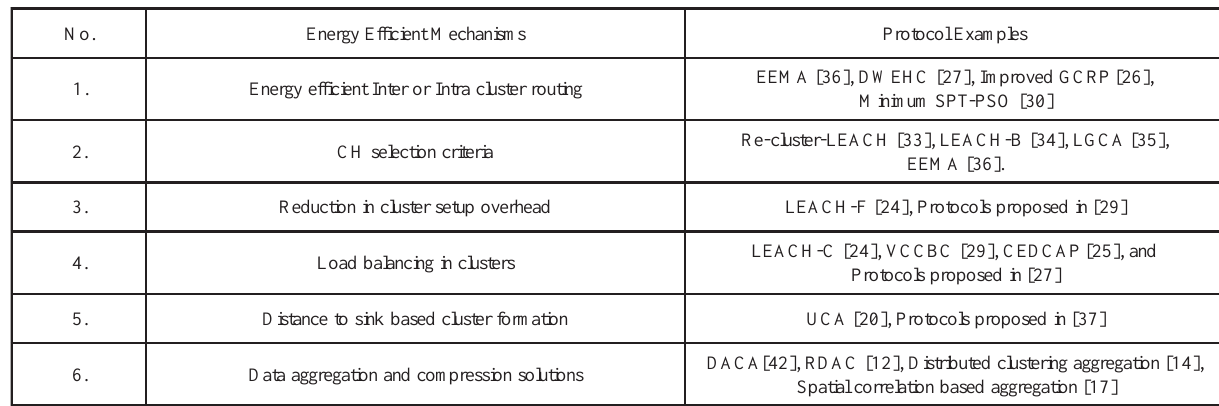
TABLE 2. ENERGY EFFICIENT MECHANISMS IN CLUSTER BASED PROTOCOLS OF